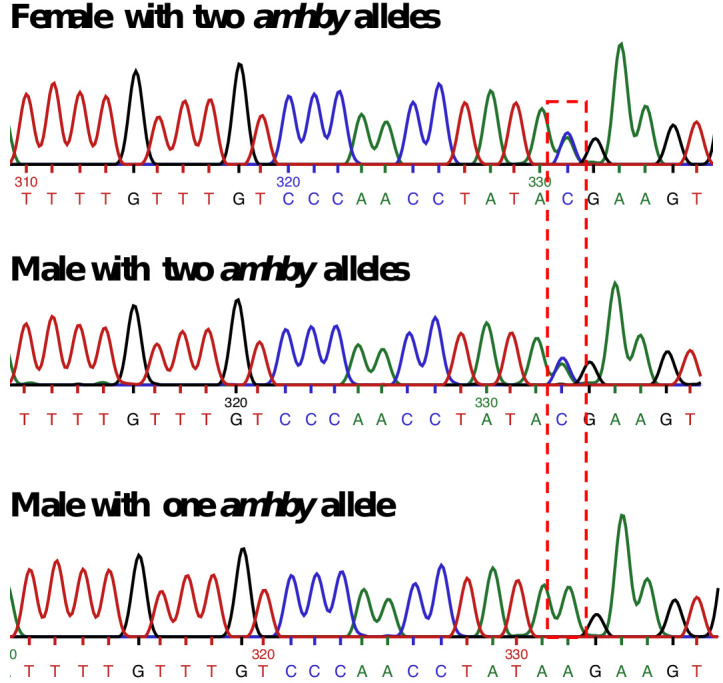
Sanger sequencing results for E. masquinongy one female and one male carrying two different alleles of amhby and one male carrying only one amhby allele.The base with a bi-allelic SNP is highlighted with the red dashed-line box.